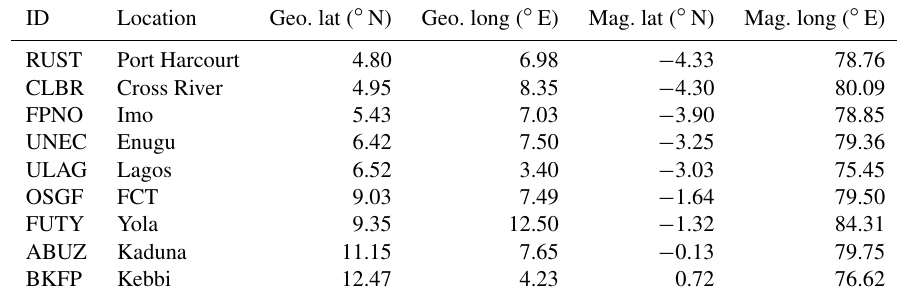
Table 1. The list of stations used in the study with their respective geographical and geomagnetic coordinates. ID Location